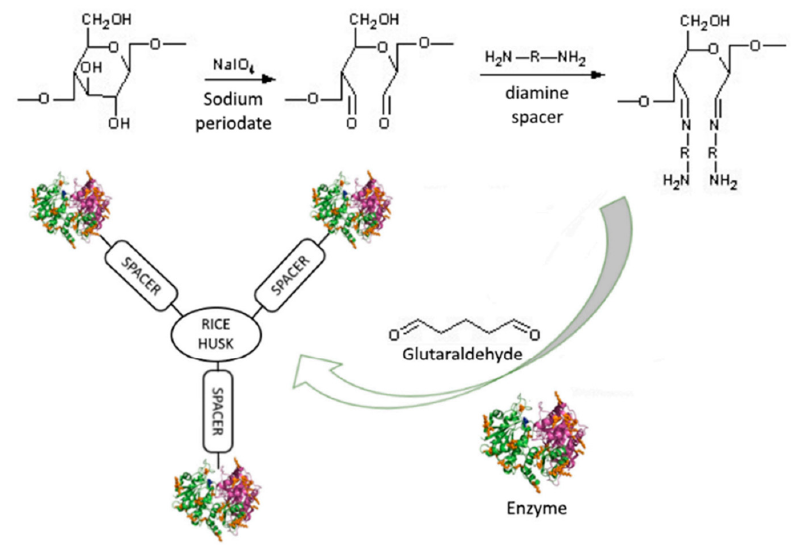
Figure 1. Schematic illustration of the oxidation and functionalization of the cellulosic fraction of RH for the covalent immobilization of Lipase B from Candida Antarctica. Reprinted with permission from Ref. [10]. Copyright 2018, MDPI.